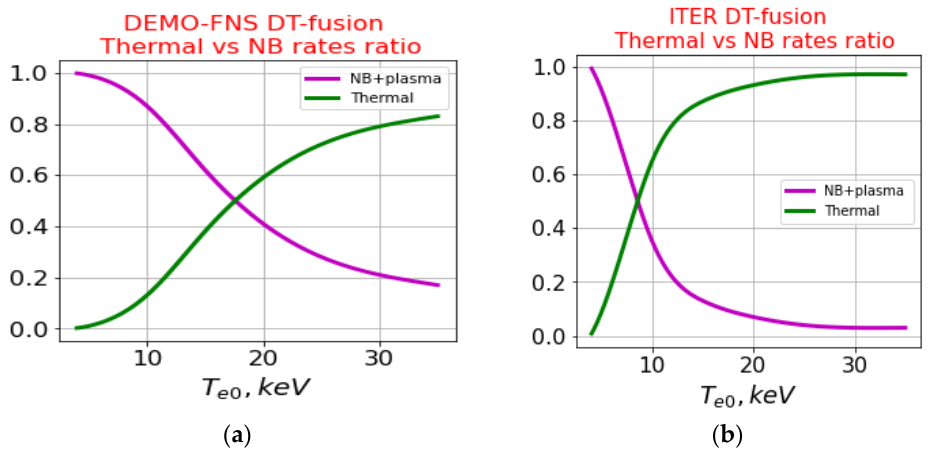
Figure 9. NBI contribution to DT fusion rates across plasma temperature: ( a ) DEMO-FNS ( n e 0 = 1 × 10 20 m −3 , E b = 500 keV); ( b ) ITER ( n e 0 = 1.2 × 10 20 m −3 , E b = 1 MeV).